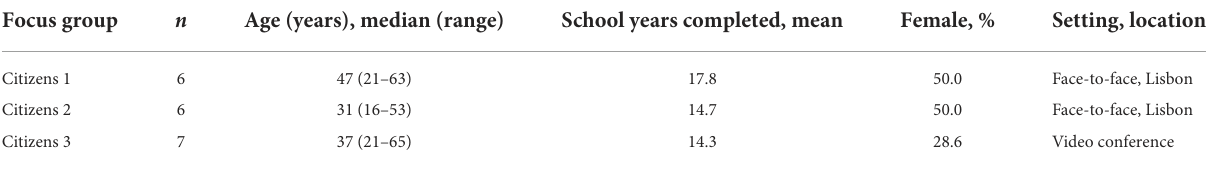
TABLE 1 Characteristics of the study participants included in the focus groups with citizens conducted to explore opinions and attitudes regarding the development of healthy eating promotion mass media campaigns. Focus group